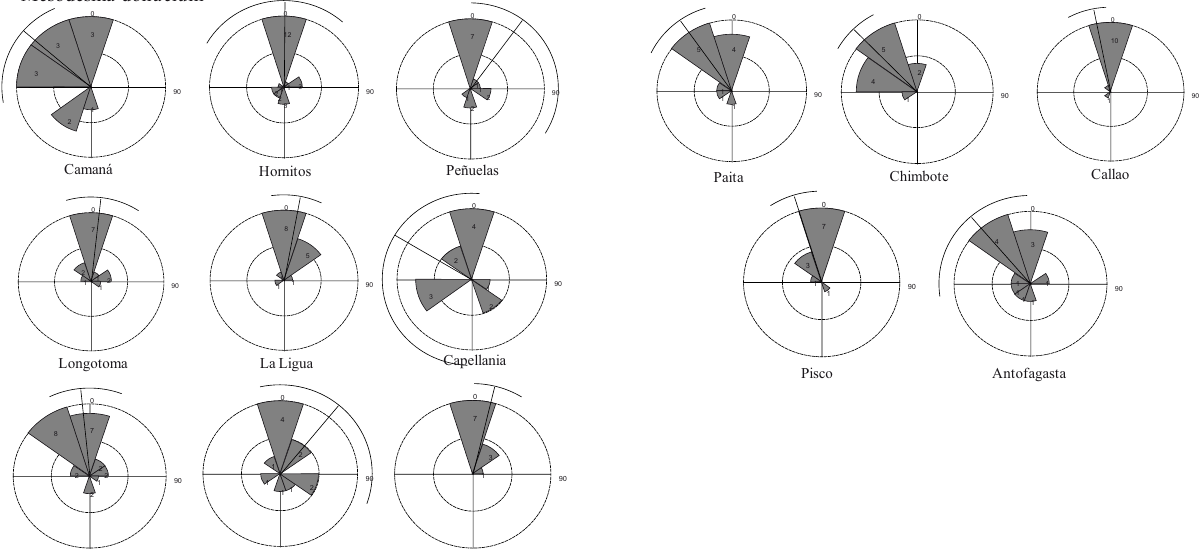
Fig . 3. – Circular representation of the gonadal stage frequency in the active phase per locality and index of dispersion and central tendency for the statistical test. Shadowed areas and numbers represent the frequency expressed in degrees. The line crossing the circle represents the middle angle ( ā ). The line outside the circle represents the variance